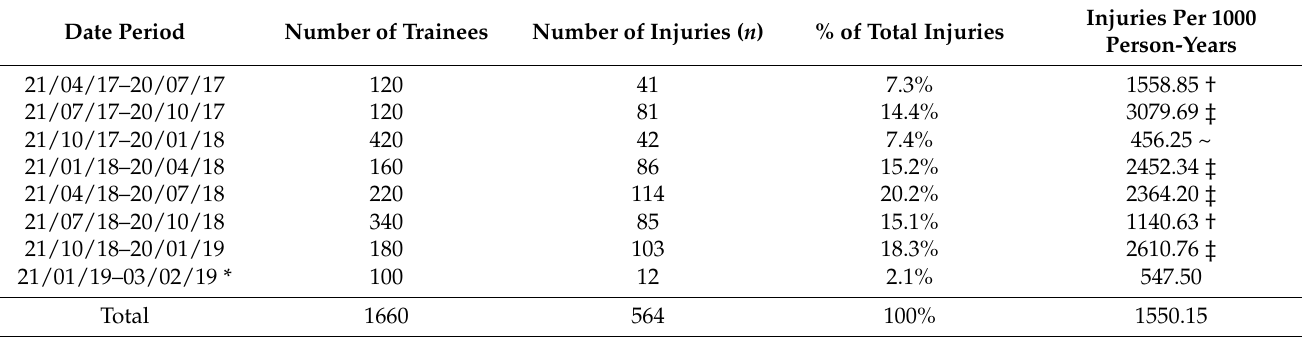
Table 1. Numbers of trainee and trainee injuries during each three-month period of